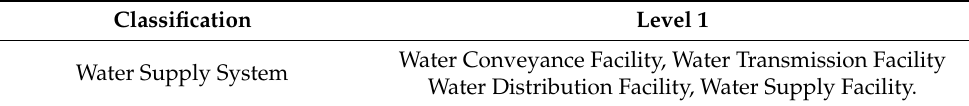
Table 3. Inventory composition of Level 1.